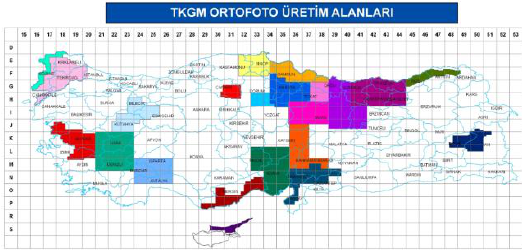
Figure 8. 1:5000 scale digital color orthophoto production